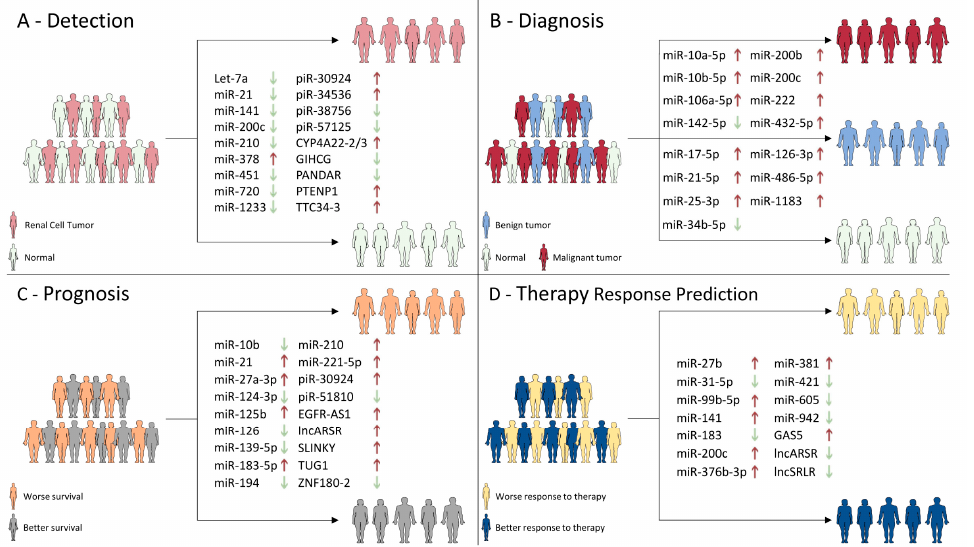
“green”—downregulated). ( B ) Besides the potential use of ncRNAs to detect tumorigenesis, some reported as capable to di ff erentiate both malignant from benign lesions, and benign from asymptomatic